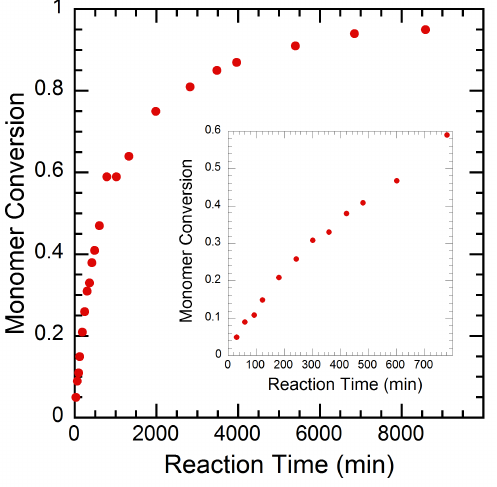
Figure 4. Polymerization kinetics (monomer conversion) of PMMA-1 as determined by 1 H NMR. The inset window highlights magnified early reaction time